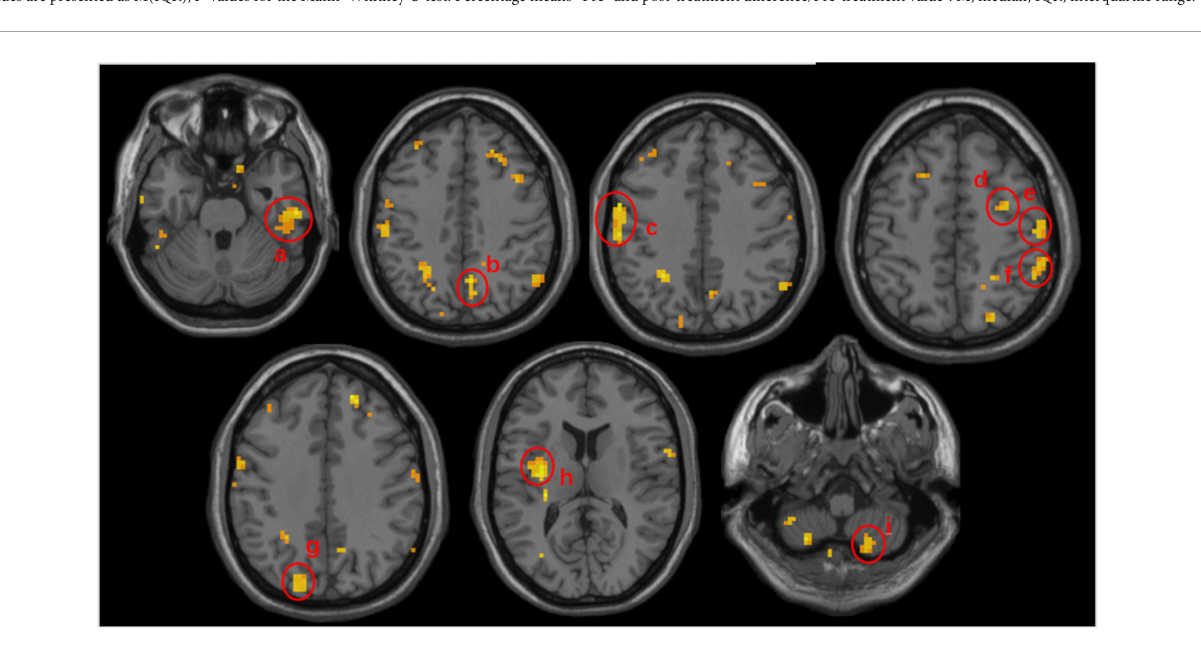
FIGURE2 Volumetric results of the subtracted ALFF values mix effect analysis between the acupuncture and control groups. Subtracted ALFF values before and after the intervention was extracted separately from ACU and CON groups and mix effect analysis was performed to compute the difference for the treatment effect. Warmer colors represent higher ALFF changes in the acu-group compared to the con-group. Peak coordinates refer to the Montreal Neurological Institute (MNI) atlas. a, the right inferior temporal gyrus; b, the right precuneus; c, the left postcentral gyrus; d, the left precentral gyrus; e, the right postcentral gyrus; f, the right superior parietal gyrus; g, the left middle occipital gyrus; h, the left insula; i, the right